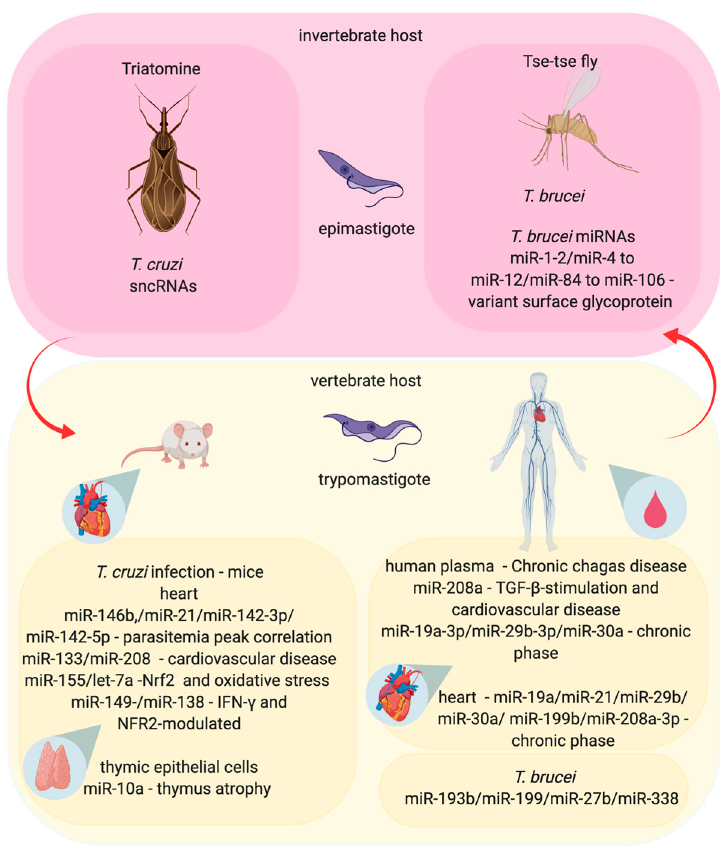
Figure 3. The influences of miRNA in the interaction between the Trypanosoma, vector, and mammalian host in Chagas disease and Sleep sickness. The Trypanosoma cruzi causes a Chagas disease and is transmitted during the Triatomine bug blood-meal, when the bug defecates and transfers trypomastigotes form to the vertebrate host. The itchy skin, due to the bug’s bite, allows the trypomastigote form to enter in the dermis, where the parasite infects any cell, di ff erentiates into amastigote form, and replicates inside the infected cells, causing the clinical symptoms of the disease. T. cruzi express small noncoding RNAs (sncRNAs) that can change the regulation of gene expression inside the invertebrate host (Triatomine). Also, T. cruzi infection can modify miRNAs expression in the human and murine heart-infected cells, in the murine thymic epithelial infected cells or circulating miRNAs in human plasma samples, impacting cardiomyopathy, parasitemia and the immune response. On the other hand, sleep sickness is caused by T. brucei. The parasite is transmitted during the blood-meal of infected tsetse flies, which inject trypomastigote form into the vertebrate host. Di ff erent from the T. cruzi infection, T. brucei trypomastigotes circulate in the blood, lymph, and spinal fluid and can cross the blood brain barrier to infect the central nervous system. This parasite expresses miRNAs correlated with the modulation of the expression of virulence factors, such as variant surface glycoproteins. The miRNA profile is altered in plasma samples of patients infected with T. brucei . Regarding T. brucei gambiense and T. b. rhodesiense , these cause a fatal human disease known as African sleeping sickness chronic illness, which is prevalent in West Africa and East Africa, respectively [130]. T. brucei is transmitted by the bite of infected tsetse flies (genus Glossina), alternating the bloodstream-form in the mammalian host (man, domestic animals, and ruminants) and insect-form of life [131]. Parasites injected in hosts cause a local inflammatory reaction, a tender reddish swelling, and the multiplication of parasites in the plasma and interstitial fluid begin an acute febrile illness. T. b. gambiense classically causes an enlargement of cervical lymph nodes and can progress to neurological diseases, such as meningoencephalitis, lethargy, and coma. Besides, T. b. rhodesiense mostly causes acute systemic diseases, such as haemolymphatic alteration, swollen lymph nodes, fever, and